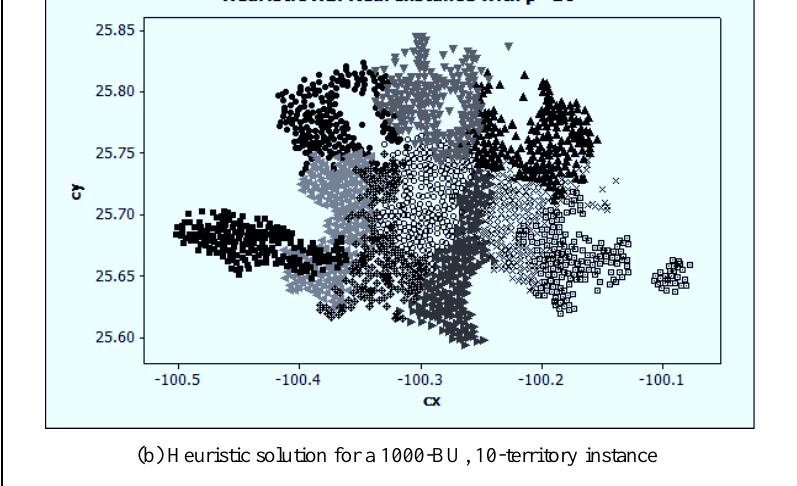
Fig. 11. Comparison between designs obtained by the firm and proposed